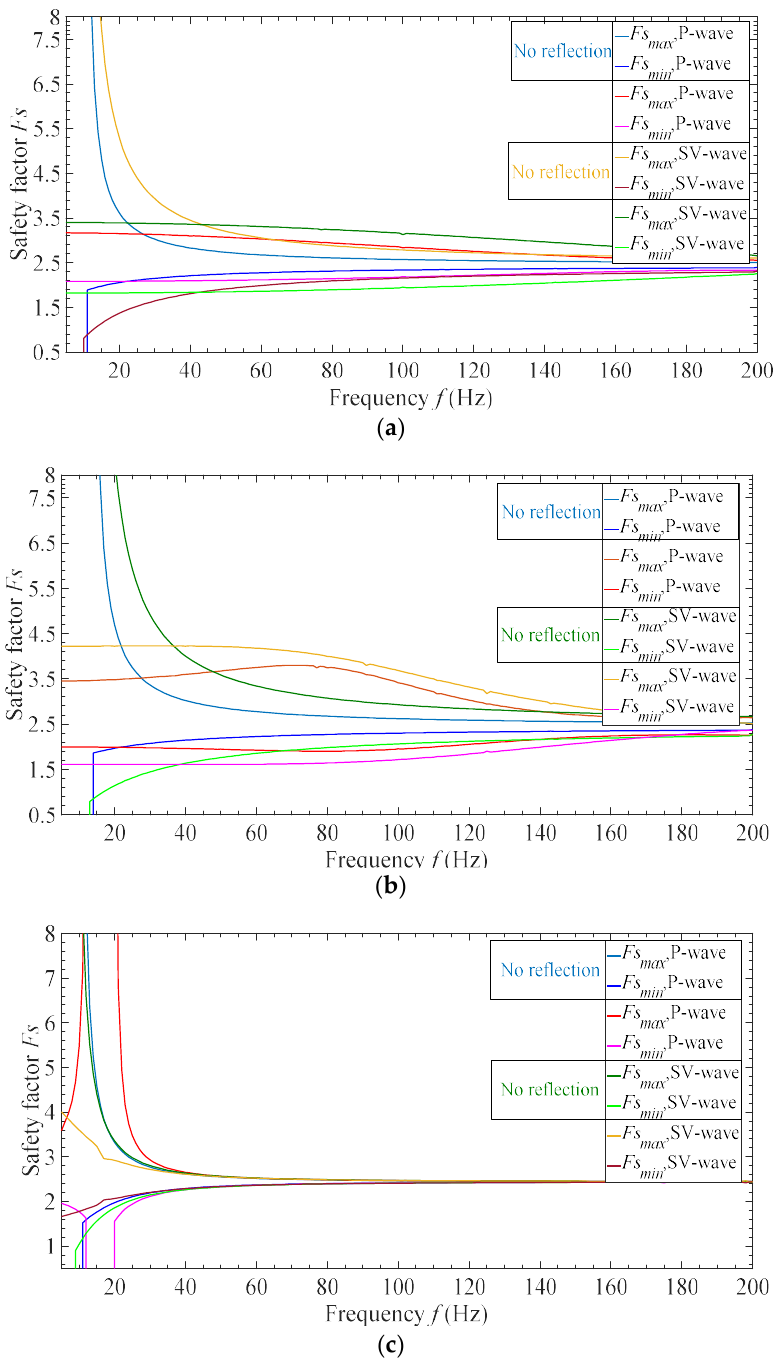
Figure 11. Comparison of free slope surface with reflection and no reflection (instantaneous safety factor vs. wave frequency): ( a ) model I; ( b ) model II; ( c ) model III.